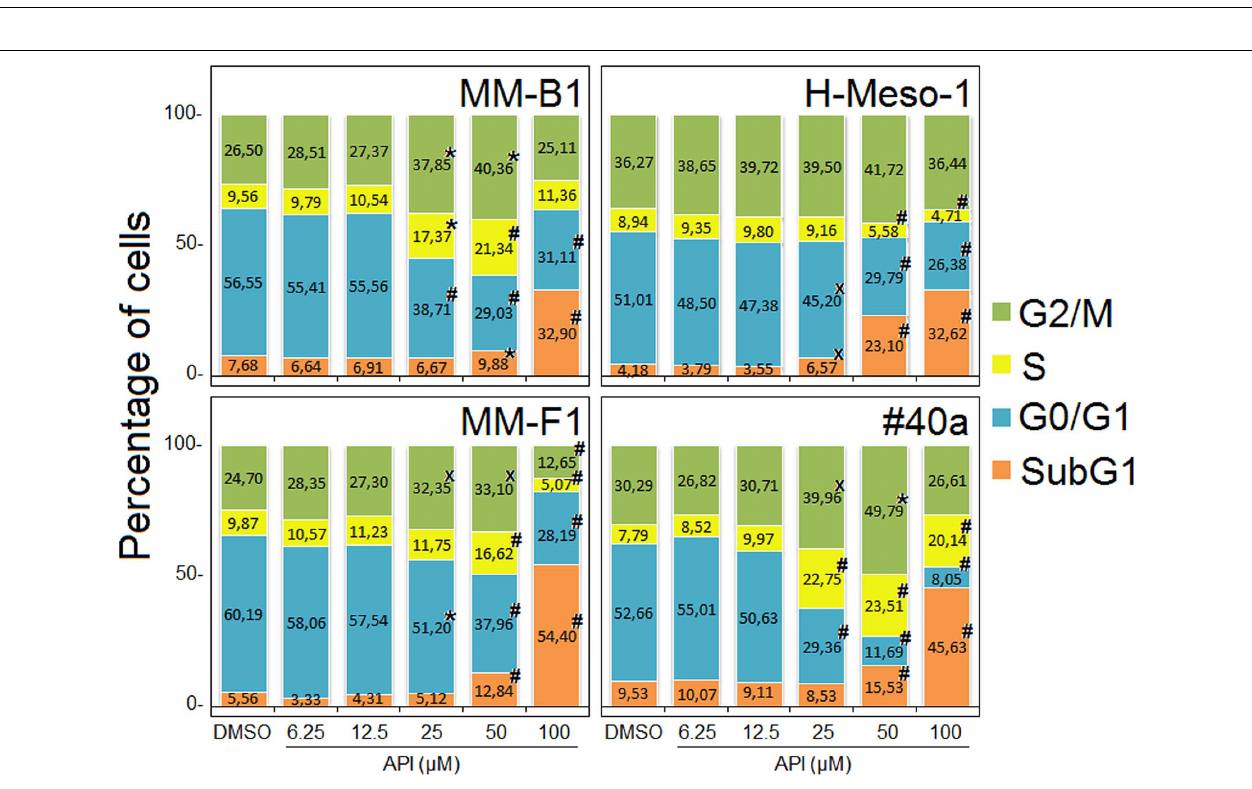
FIGURE 7 | Stacked bar graphs showing the percentage of cells in different phases of the cell cycle. Percentage of cells in subG1, G0/G1, S, and G2/M phases was calculated with CellQuest Pro 5.2 software. Results represent mean values from three independent experiments. Statistical significance of the effects obtained with API treatment was calculated vs. those obtained in DMSO-treated cells with one-way ANOVA analysis of variance ( x p ≤ 0.05, ∗ p ≤ 0.01, # p ≤ 0.001).